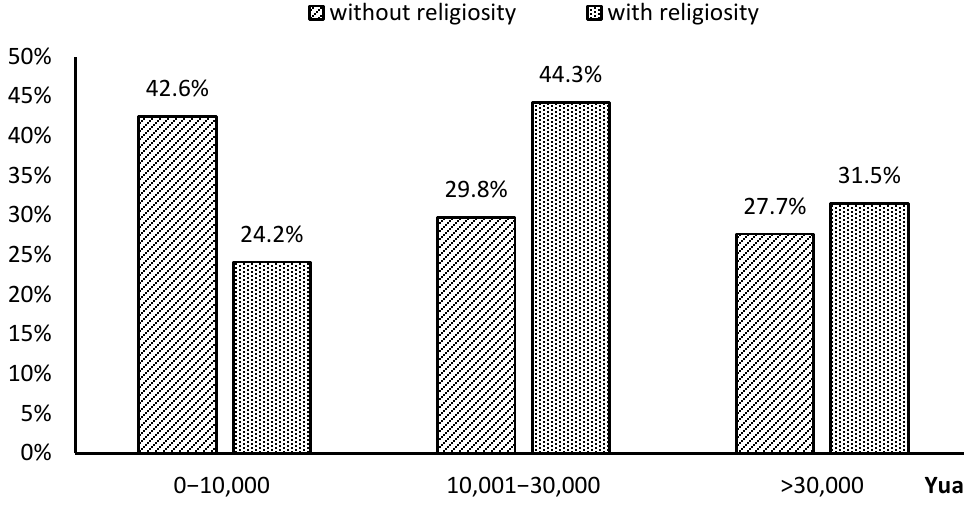
Figure 4. The ratio comparison between herders with religiosity and without religiosity in different levels of non-animal husbandry income.